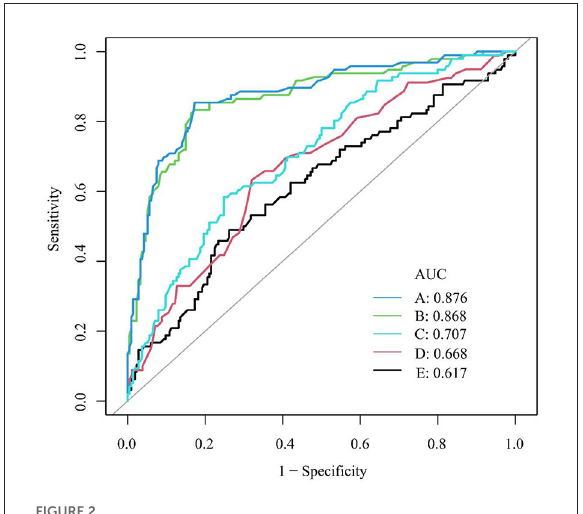
FIGURE2 ROC curve for AA retention. (A) Duration of intraoperative mechanical ventilation (min); (B) operative duration (min); (C) hemorrhage volume (ml/kg); (D) maximum tumor diameter (mm); (E) BMI (kg/m 2 ). AUC, area under the ROC curve; BMI, body mass index; ROC, receiver operating